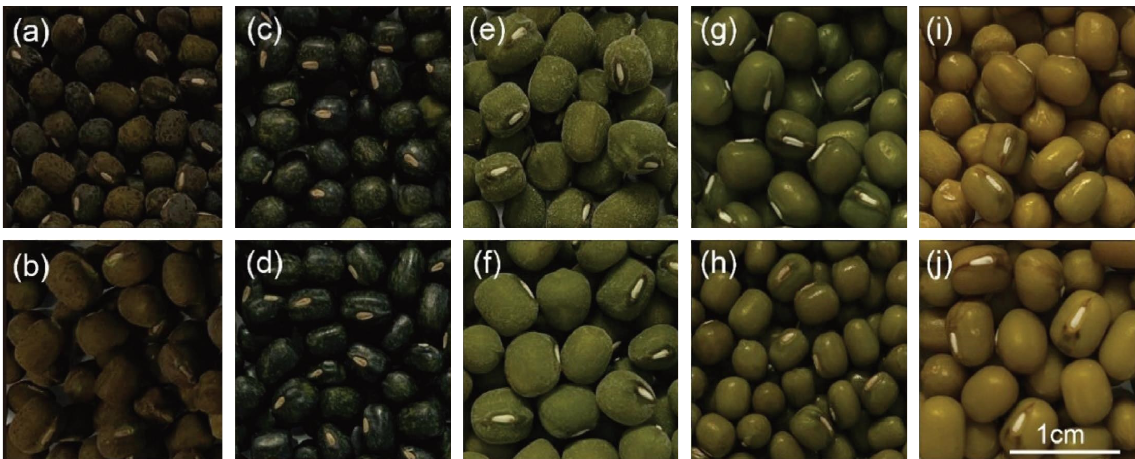
Figure 1: Seeds of 10 mungbean genotypes with diferent seed coat colors. (a) Damyang, Jeollanam-do-1994231, (b) Tecer-Hitam, Table 1: List of mungbean genotypes. Te yield was measured at 100 seed weight and the fresh weight of the sprouts.